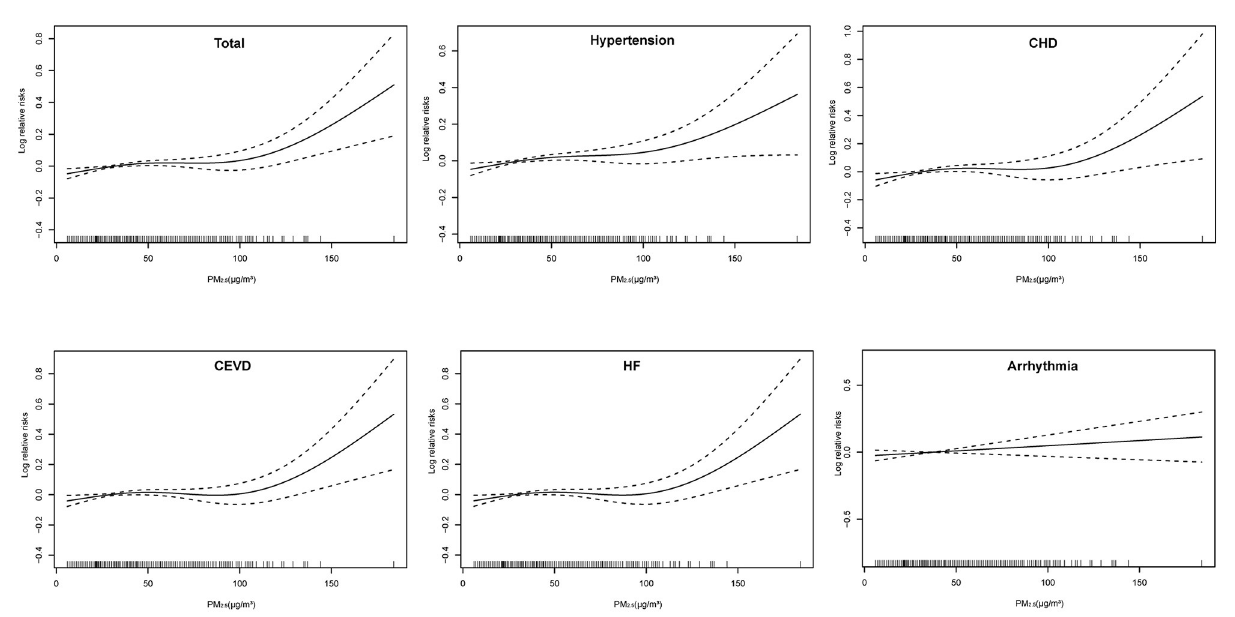
FIGURE2 Exposure-response relationships of PM 2.5 concentrations with daily hospital admissions for total and cause-specific circulatory system diseases. CEVD, Cerebrovascular Disease; CHD, Coronary Heart Disease; HF, Heart Failure. The concentration response curve is the solid line and the 95% CI is presented by the dotted